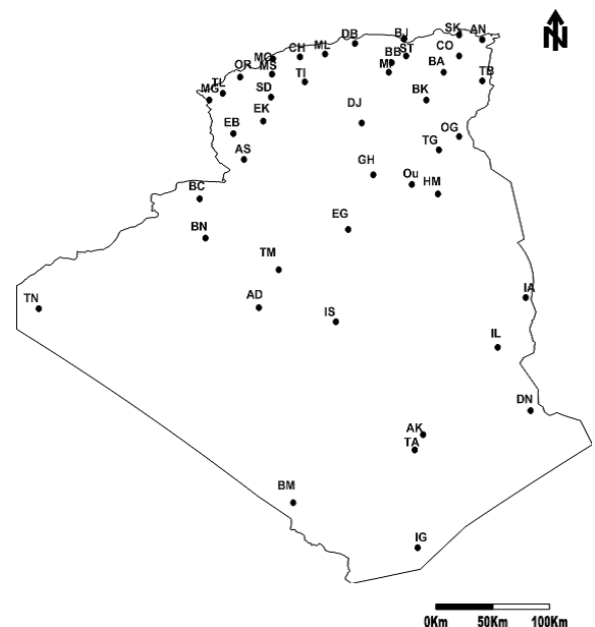
Figure 4. Location of meteorological stations analyzed (1970– 2008).